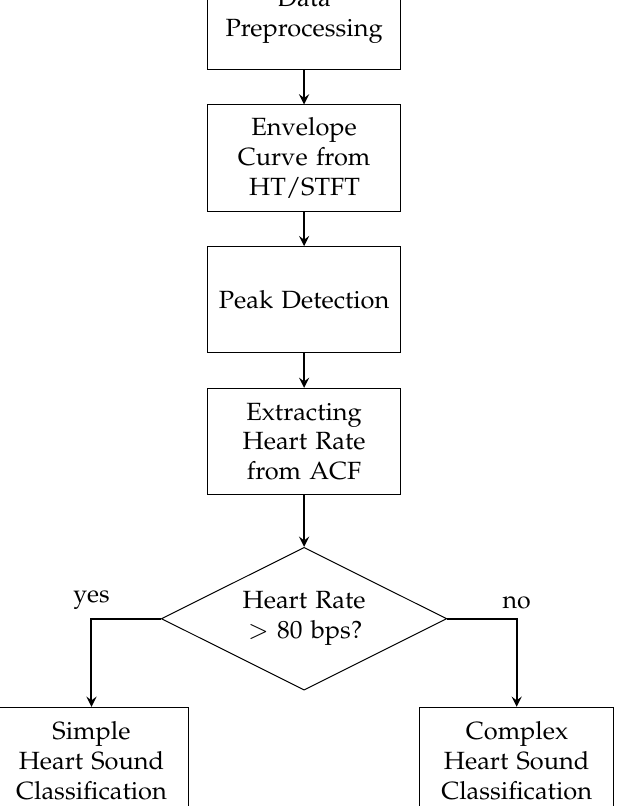
Figure 2. Flowchart of the proposed algorithm for the detection and classification of heart sounds.